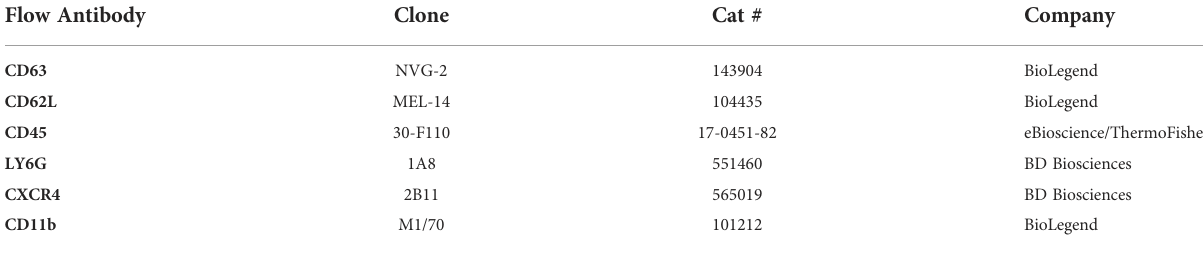
TABLE 1 Antibodies used for fl ow cytometry. Flow